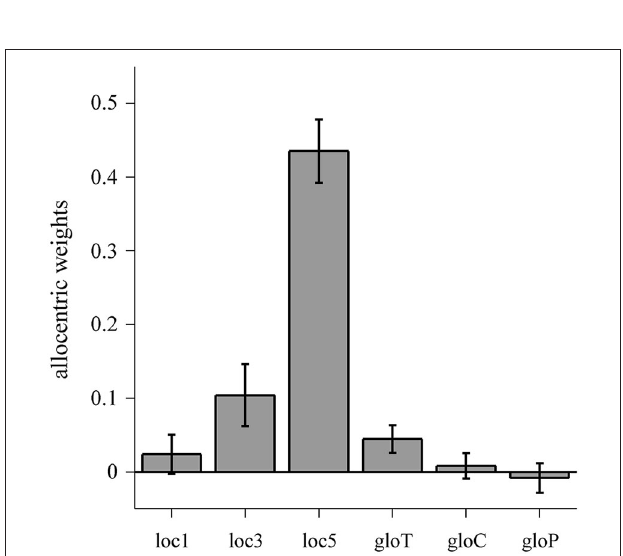
FIGURE 6 | Allocentric weights for the allo-local and allo-global conditions . Data are averaged over individual allocentric weights with error bars denoting one standard error of variability between observers. Individual allocentric weights range from − 0.15 to 0.18 (loc1), − 0.14 to 0.39 (loc3), 0.21 to 0.61 (loc5), − 0.06 to 0.14 (gloT), − 0.09 to 0.10 (gloC) and − 0.16 to 0.08